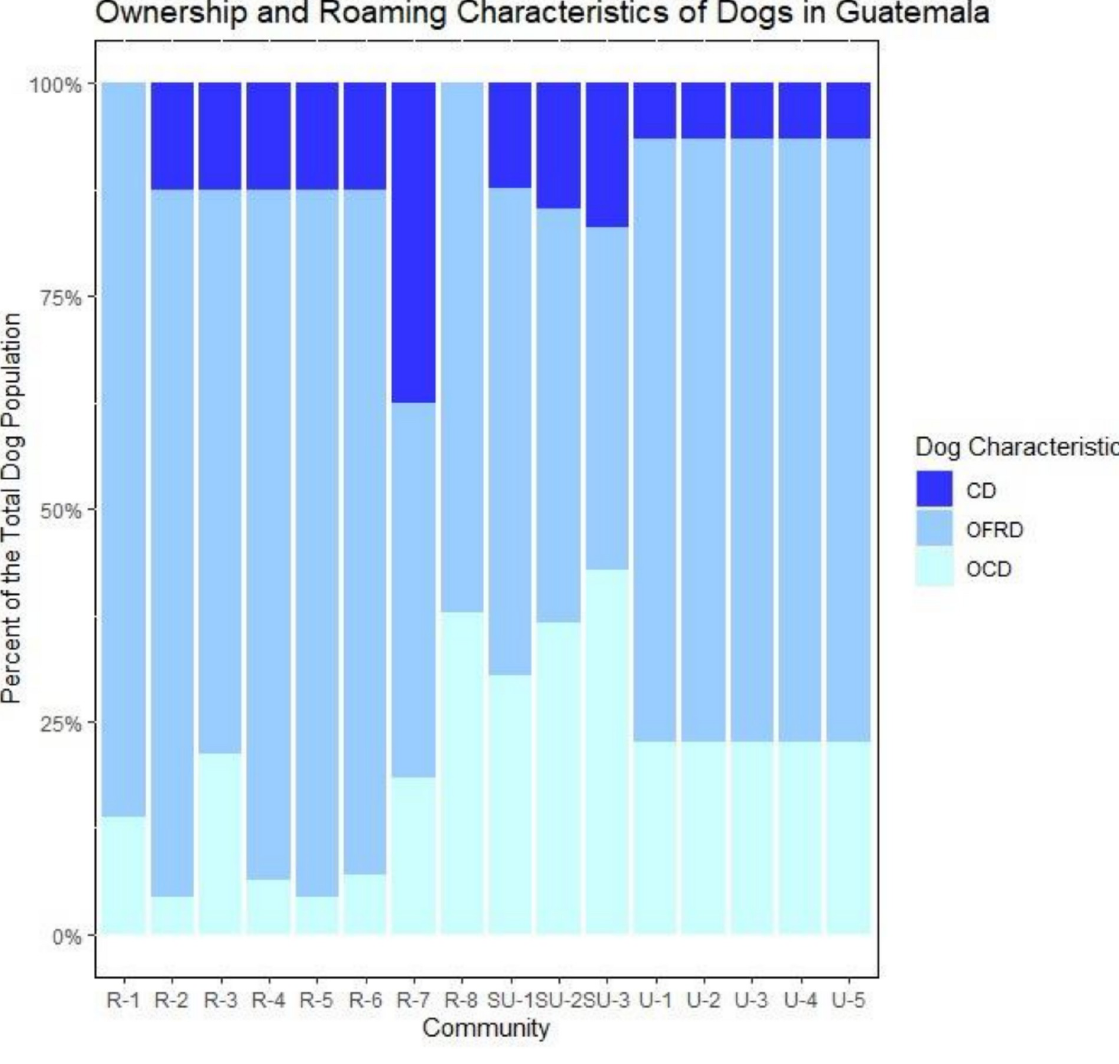
Fig 5. Ownership and roaming characteristics of the dog population among the surveilled